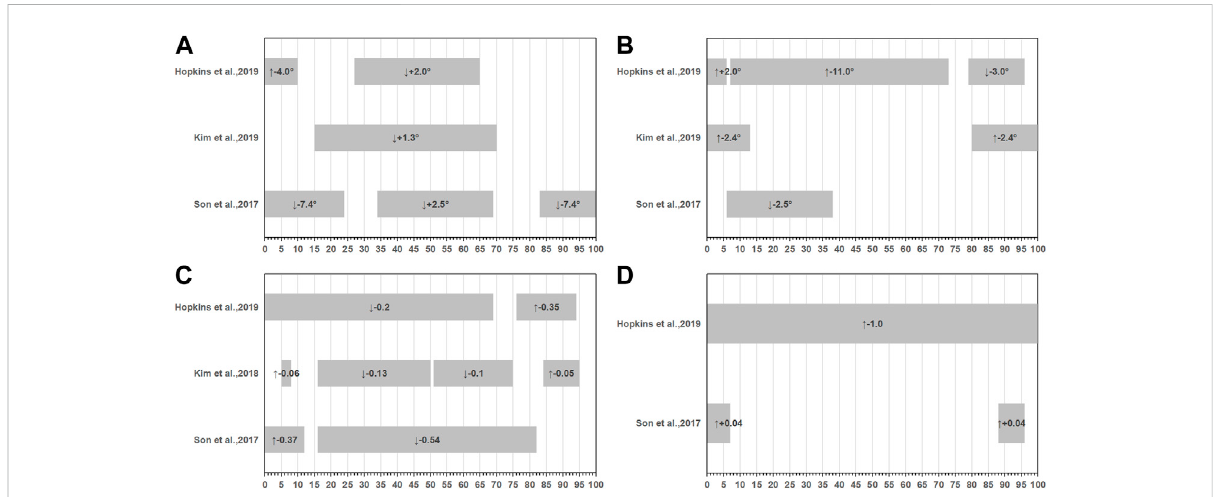
FIGURE 4 Summary of ankle joint kinematics or kinetics during double-leg take-off jump with a single-limb landing and 90 ° cut task. (A) Sagittal ankle angles, (B) Frontal ankle angles, (C) Sagittal ankle movements, (D) Frontal ankle movements. (-): plantar fl exion or inversion, (+): dorsi fl exion or eversion, ( ↑ ): variables increased compared to the health group, ( ↓ ): variables decreased compared to the health